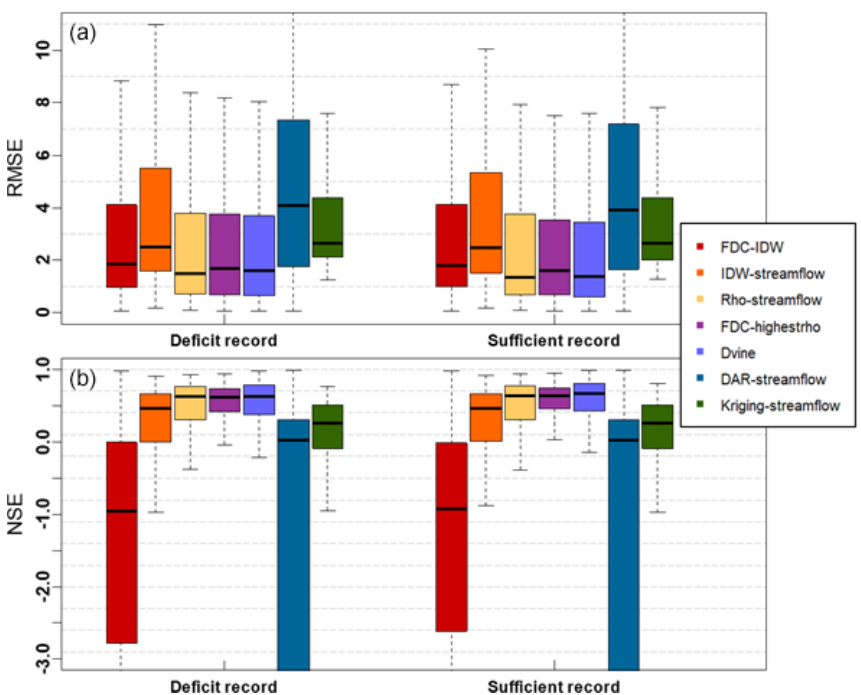
Figure 8. Intermodel comparison using cross-validation experiments based on RMSE (a) and NSE (b) . Here, lower RMSE suggests more accurate estimations for infilling missing values.